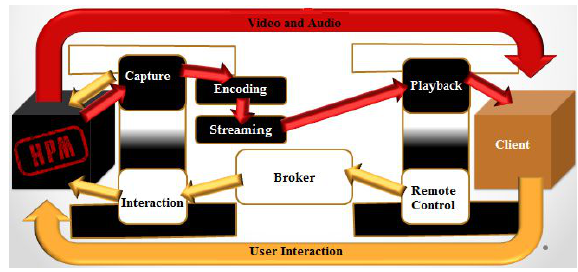
Figure 2. Components Diagrams of HPM Interaction Solution